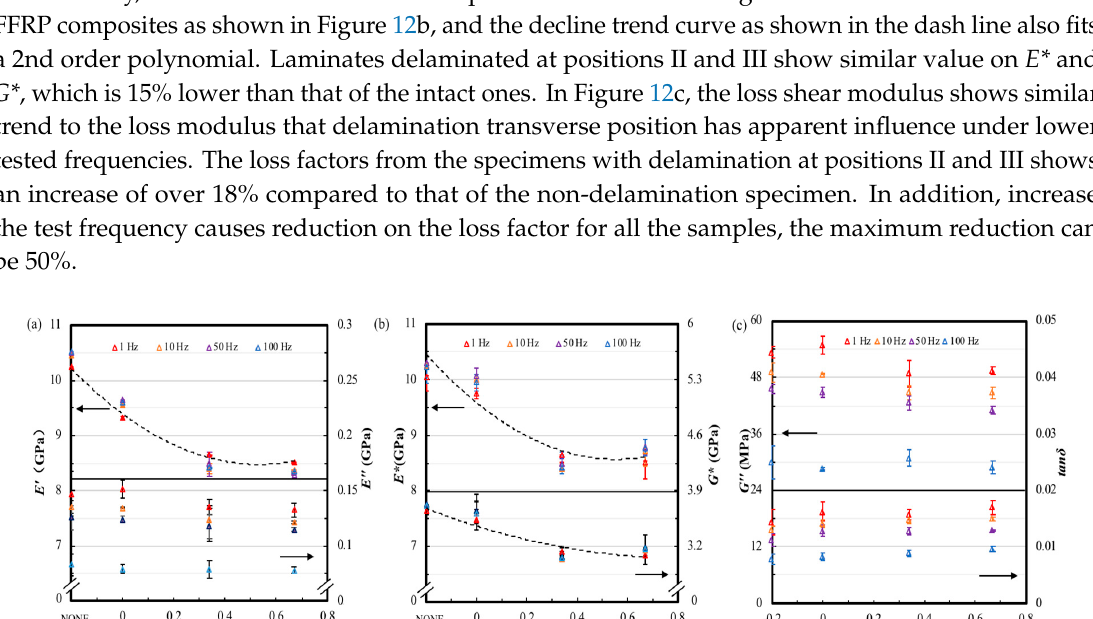
Figure 13. The dynamic mechanical properties of FFRP with different transverse delamination position tested at 25 °C, frequencies of 10 Hz, amplitude of 10, 15, 20, 25, and 30 µm. Variation of ( a ) E’ and E’ , ( b ) E* and G* and ( c ) tan δ with transverse delamination position. 4. Discussion